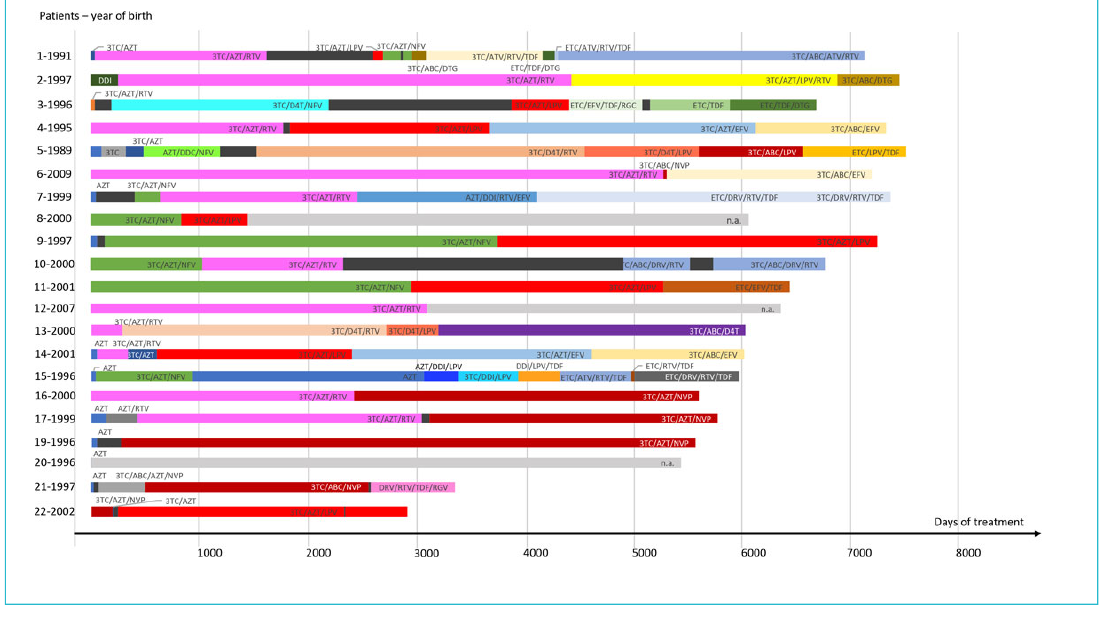
Figure 2: Circular phylogram of mother and child viral RNA and proviral DNA sequences. The diversity and evolution of HIV-1 protease sequences from RNA and proviral DNA over time is shown. Sequences that cluster together due to common origin and subtype are marked in different colours for subtype B, subtype C, subtype CRF18_cpx, subtype A1, subtype A1C, and subtype CRF67_01B.M = mother; C = child; R = RNA; P = proviral DNA; date = sampling